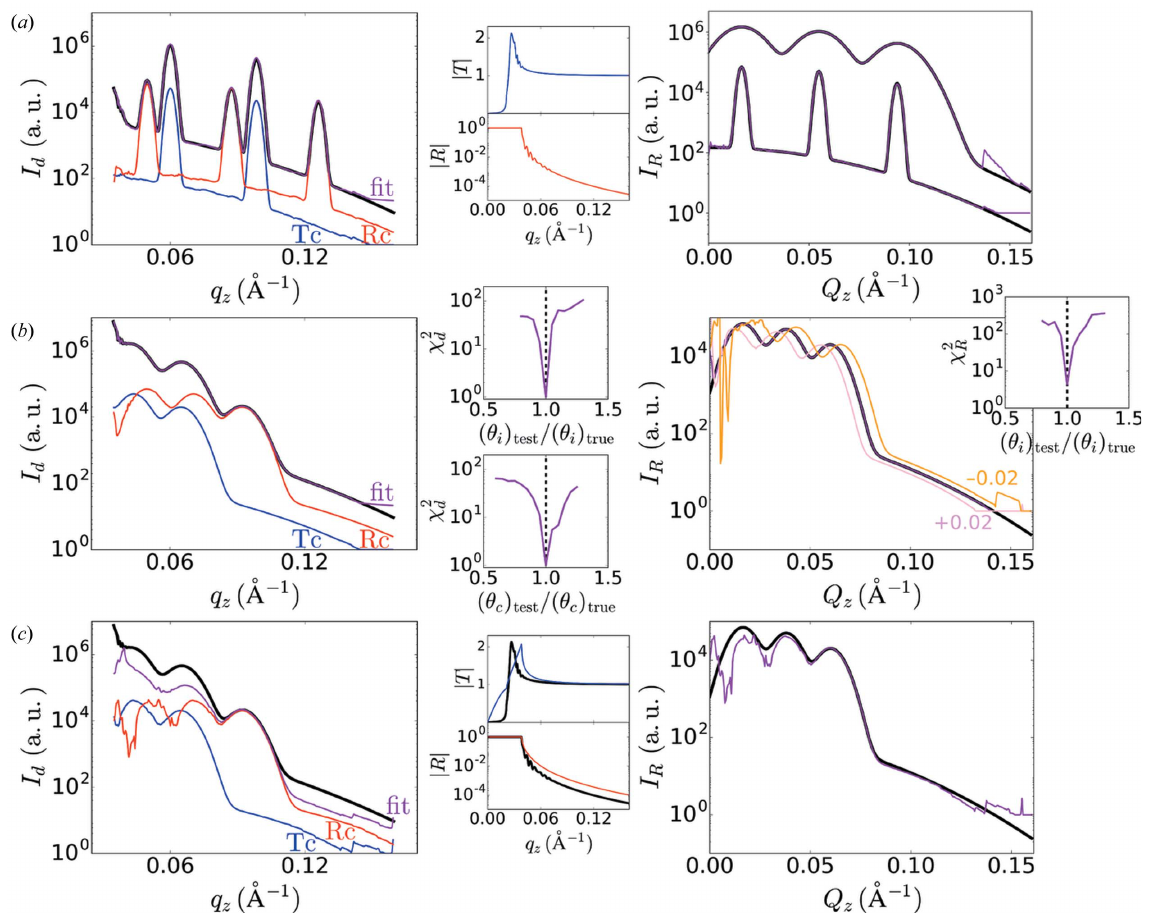
Figure 8 ð q Þ (example on left) can be Sensitivity of reconstruction method, evaluated using synthetic data. ( a ) The input synthetic GISAXS data (black curve), I z d ð Q Þ , right]; the corresponding transmission channel (blue I iteratively fitted (purple curve), from which we reconstruct the undistorted scattering [ I ) R z d ; Tc and reflection channel (red I ) components are calculated using the known transmission ( j T j ) and reflectivity ( j R j ) curves (shown in center). Two d ; Rc different examples (right) are shown (reconstruction shown in purple, true scattering in black), demonstrating that the method works for sharp and diffuse features (with artifacts appearing towards the edges of the available q range). ( b ) The method is relativity robust to errors in the assumed z incident angle ( (cid:4) ) and film critical angle ( (cid:4) ). For a typical data set (left) with intentional errors introduced into (cid:4) , the reconstruction becomes i c i correspondingly shifted (right, numbers indicate intentional error in (cid:4) ). The fit-error ( (cid:6) 2 ) with respect to errors in the angles has a deep minimum at the d i true value, allowing this value to also be iteratively refined. ( c ) Errors in the assumed transmission and/or reflectivity curves necessarily corrupt the reconstruction. However, for modest errors in these curves, the reconstruction remains qualitatively correct. In the example presented here, incorrect transmission and reflectivity curves were used intentionally (center; true curves in black). The resulting reconstruction (right) exhibits artifacts yet nevertheless maintains the correct overall shape and